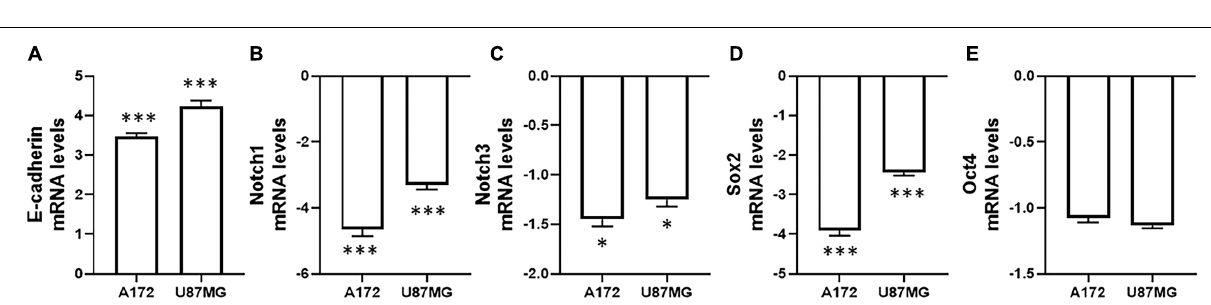
Frontiers in Cell and Developmental Biology |